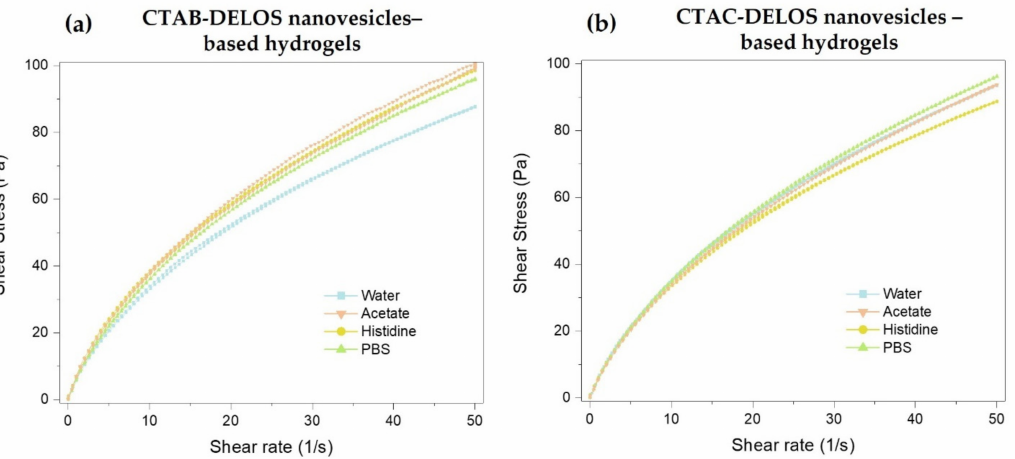
Figure 6. Shear rate as a function of shear stress of hydrogels enriched with ( a ) CTAB-DELOS nanovesicles and ( b ) CTAC-DELOS nanovesicles in different dispersant media: water (blue (cid:4) ); 5 mM acetate, pH = 5.0 (orange (cid:72) ); 5 mM histidine, pH = 7.0 (yellow • ); and 5 mM PBS, pH = 7.4 (green (cid:78)